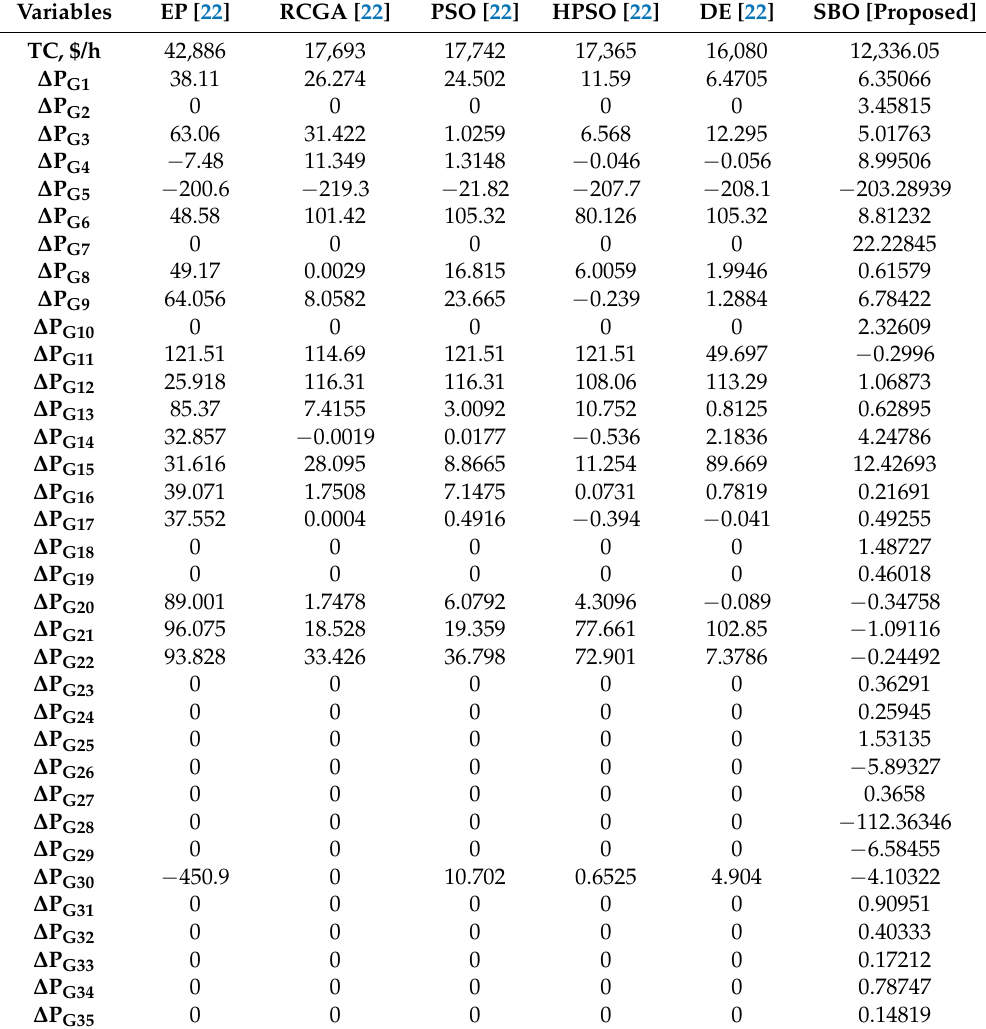
Table 5. Comparison of simulation results for IEEE 118-bus test power system.EP: evolutionary programming algorithm, RCGA: real coded genetic algorithm, PSO: particle swarm optimization, HPSO: hybrid particle swarm optimization, DE: differential